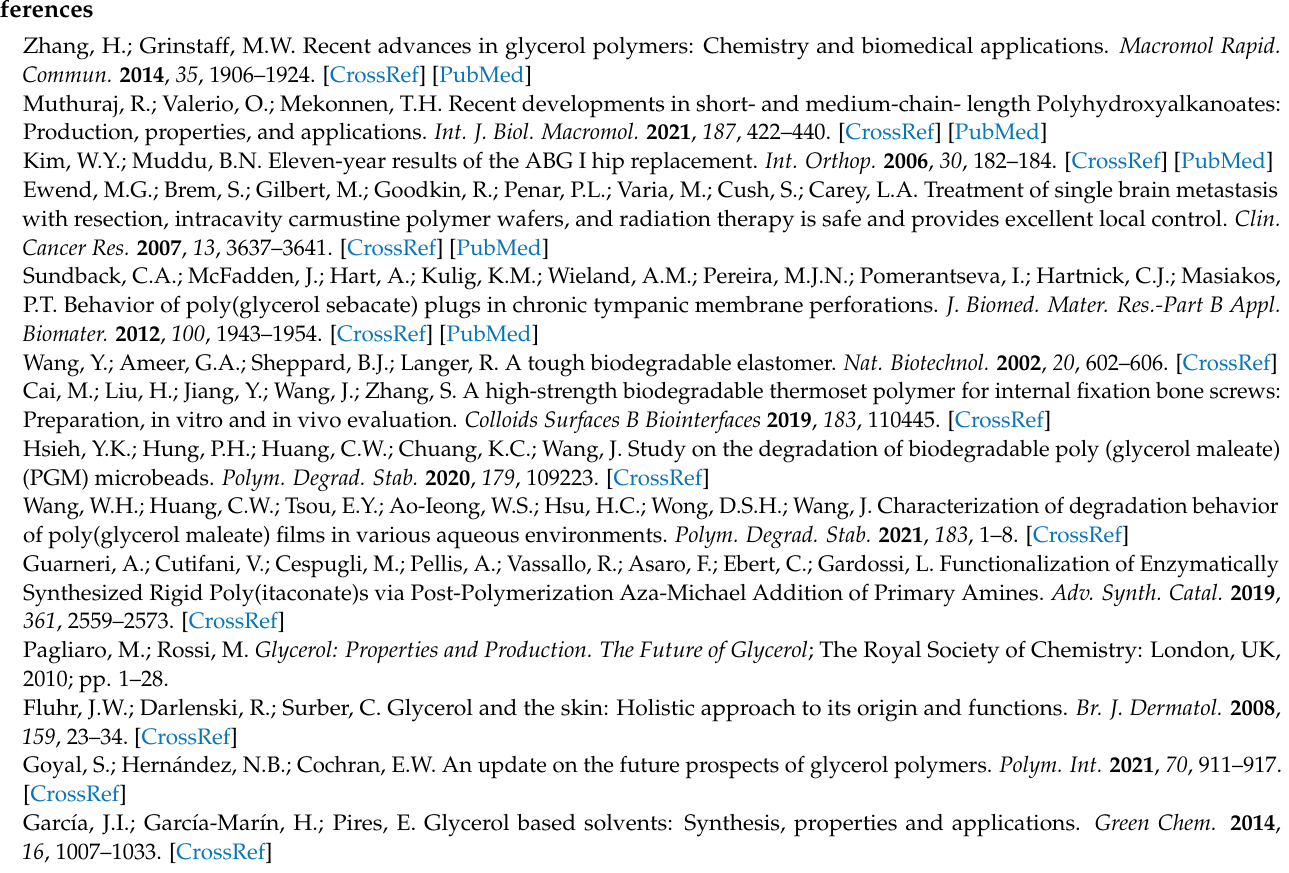
Figure S3: Pareto chart for the ED NMR variable. Figure S4: Pareto chart for the %X 13CNMR variable. Figure S5: Profile of approximated values of input variables and utility. Table S1: Significance test of regression equation coefficients for the ED titr variable. Table S2: Model adequacy test for the ED titr variable. Table S3: Significance test of regression equation coefficients for the ED NMR variable. Table S4: Model adequacy test for the ED NMR variable. Table S5: Significance test of regression equation Table S7: Values of output variables to generate the response utility